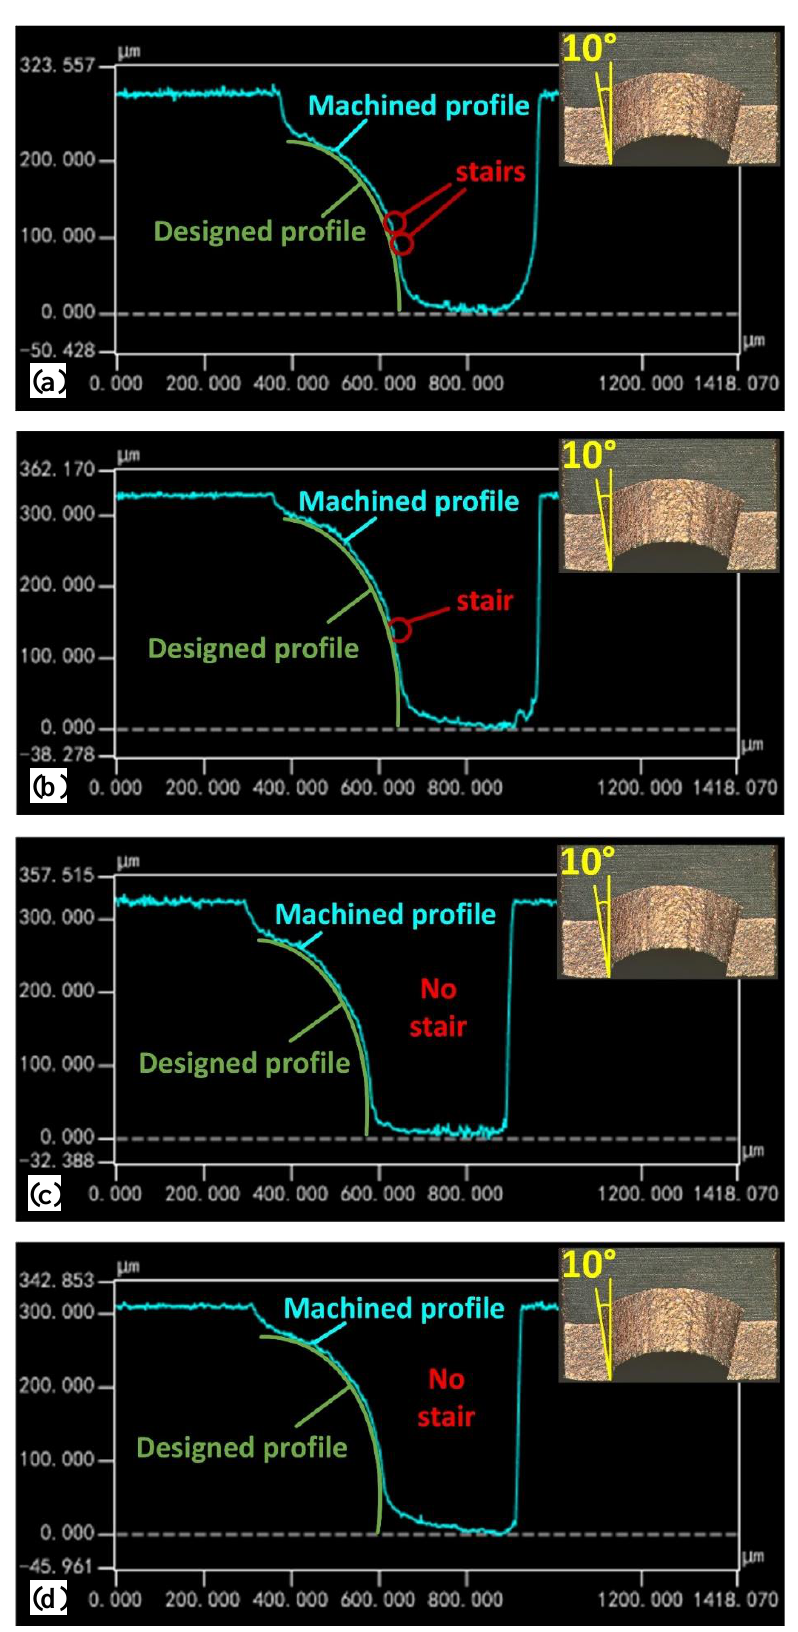
Figure 7. Micro-EDM results of FQ-microelectrodes with different number of F-microelectrodes observed by laser scanning confocal microscopy: ( a ) 16; ( b ) 25; ( c ) 33; ( d ) 40.